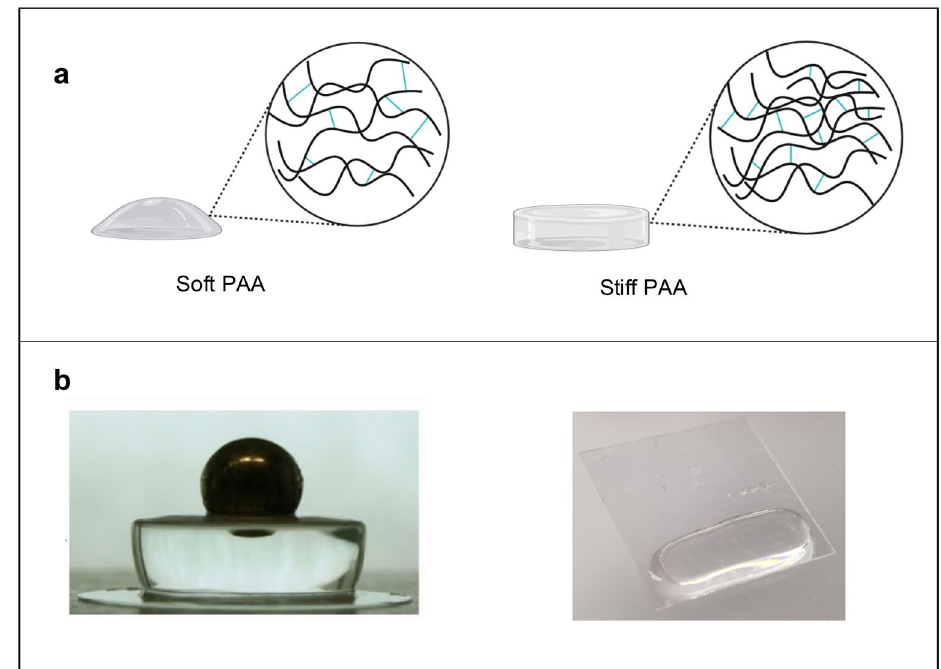
Figure 1. ( a ) Scheme of PAA hydrogels soft and stiff and ( b ) example of sample geometries used for macroindentation (left) and micropipette aspiration (right) tests.